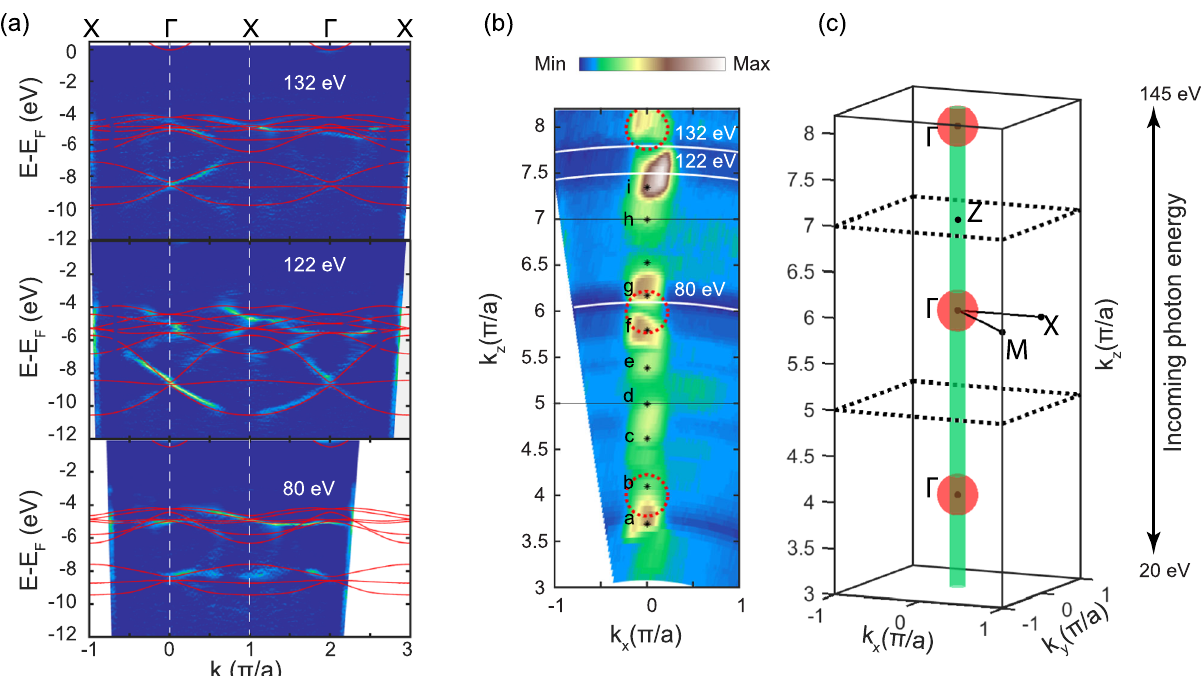
Fig. 2 Surface and bulk electronic structure of La-doped BaSnO 3 . a Valence band dispersion parallel to Γ -X, acquired with incoming photon energies of 80, 122, and 132 eV, corresponding to different perpendicular momentum k z values as indicated by the white curves in ( b ). The measured band structure is overlaid with the LQSGW band structure calculated for bulk BaSnO 3 . The measured and calculated bands show good agreement, with a clear dispersion along k z . b Intensity map at the Fermi energy in the plane perpendicular to the sample surface ( k x – k z ), measured with incoming photon energies ranging from 20 to 145 eV. No clear periodicity is evident along k z . The black squares indicate the Brillouin zone boundaries as inferred by the periodicity of the valence bands shown in panel ( a ), using the LQSGW calculations as a reference. The red circumferences mark the expected bulk Fermi surface centered at the Γ points ( c ) Sketch illustrating the difference between the measured and calculated Fermi surfaces. The calculated 3D sphere-like Fermi surface with Fermi momentum k F based on the nominal doping of the fi lm is shown in red, while the measured 2D cylinder-like Fermi surface with k F based on the measurements results is shown in green. ARPES intensity follows the attached color scale bar.